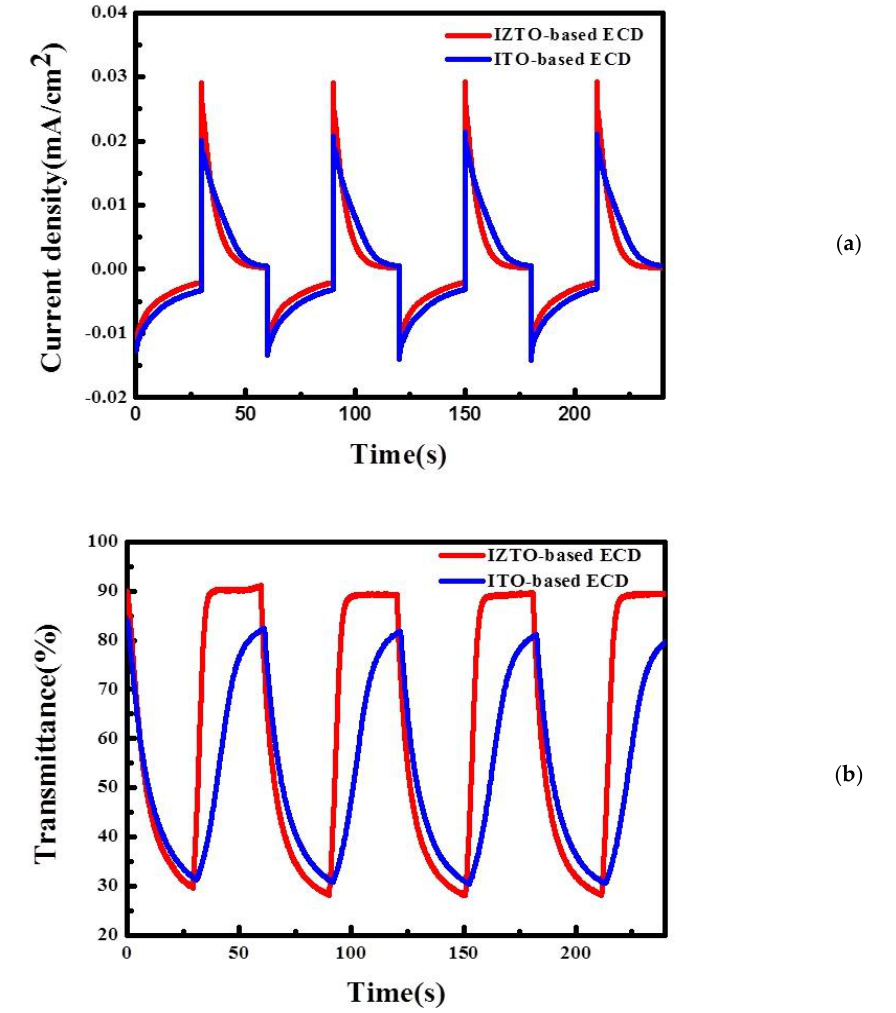
Figure 7. ( a ) The current density; ( b ) the variation in the optical transmittance at 633 nm for IZTO- based and ITO-based ECDs.